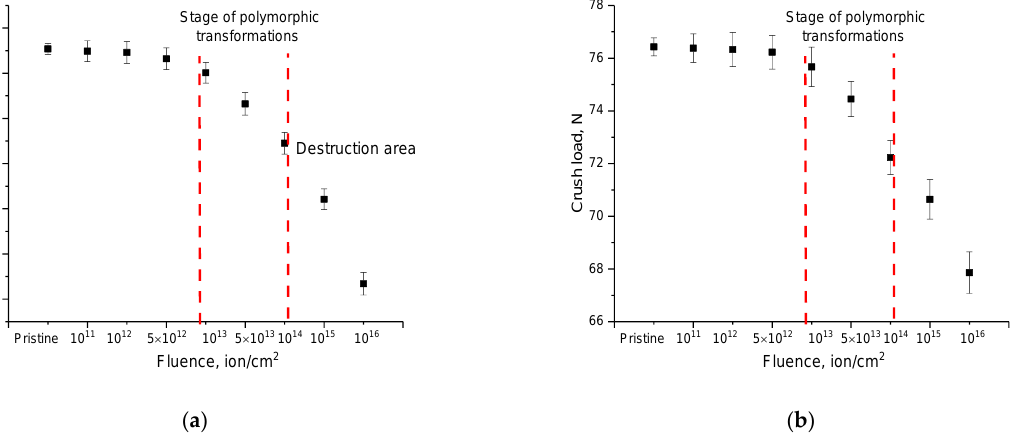
Figure 8. ( a ) Results of the assessment of changes in the hardness of the near-surface damaged layer depending on the irradiation fluence; ( b ) Results of the assessment of changes in the value of the maximum pressure the ceramics were capable of withstanding under a single compression.